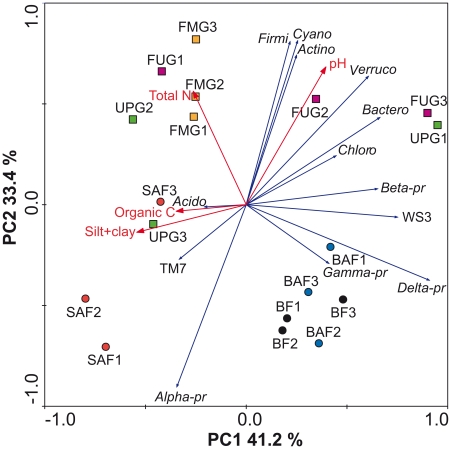
Principal components analysis of bacterial communities as affected by land use, based on the relative abundance of bacterial phyla and proteobacterial classes.Every vector points to the direction of increase for a given variable so that soil samples with similar bacterial communities are localized in similar positions in the diagram. The spruce age class forest (SAF1-3), beech age class forest (BAF1-3), and unmanaged beech forest (BF1-3) sampling sites are marked by the red, green, and black circles, respectively. The fertilized intensely managed grassland (FUG1-3), fertilized mown pasture grazed by horse and cattle (FMG1-3), and unfertilized pasture grazed by sheep (UPG1-3) sampling sites are depicted by red, green, and black squares, respectively. Abbreviations in figure: Firmi, Firmicutes; Cyano, Cyanobacteria; Actino, Actinobacteria; Verruco, Verrucomicrobia; Bactero, Bacteroidetes; Chloro, Chloroflexi; Beta-pr, Betaproteobacteria; Delta-pr, Deltaproteobacteria; Gamma-pr, Gammaproteobacteria; Alpha-pr, Alphaproteobacteria; Acido, Acidobacteria.